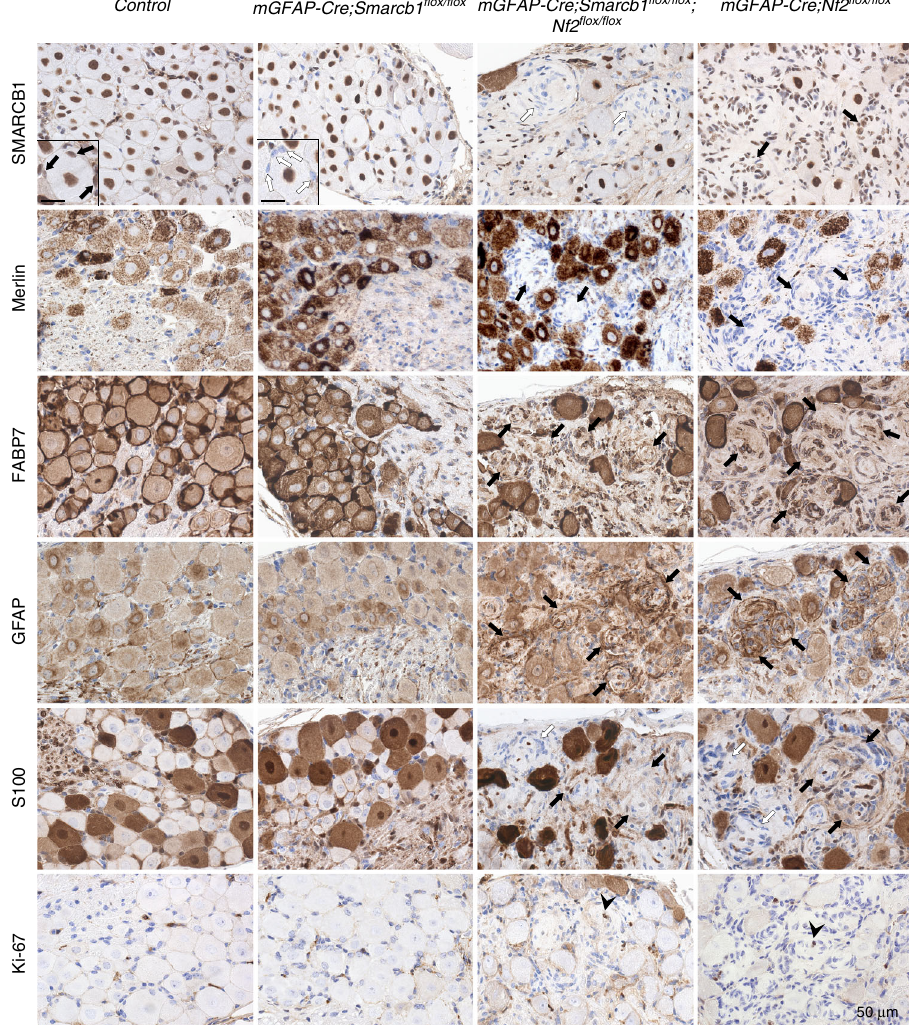
Fig. 6 Histological characterization of DRGs and schwannoma tumorlets in control, mGFAP-Cre;Smarcb1 fl ox/ fl ox , mGFAP-Cre;Smarcb1 fl ox/ fl ox ;Nf2 fl ox/ fl ox , and mGFAP-Cre;Nf2 fl ox/ fl ox mice. DRGs from mGFAP-Cre;Smarcb1 fl ox/ fl ox mice present loss of SMARCB1 nuclear staining ( white arrows ), but no tumorlets or increased Ki-67 immunopositive staining. Tumorlets in DRGs of mGFAP-Cre;Smarcb1 fl ox/ fl ox ;Nf2 fl ox/ fl ox mice show loss of both SMARCB1 and merlin ( white and black arrows ), and tumorlets in DRGs of mGFAP-Cre;Nf2 fl ox/ fl ox mice show loss of merlin only ( black arrows ). Both tumorlets from mGFAP-Cre; Smarcb1 fl ox/ fl ox ;Nf2 fl ox/ fl ox and mGFAP-Cre;Nf2 fl ox/ fl ox mice show strong positive staining for FABP7 and GFAP ( black arrows ). Tumorlets from these both genotypes are S100 positive ( black arrows ) or negative ( white arrows ). Ki-67 positive staining is found in tumorlets of both mGFAP-Cre;Smarcb1 fl ox/ fl ox ; Nf2 fl ox/ fl ox and mGFAP-Cre;Nf2 fl ox/ fl ox mice ( arrowhead ). Inset scale bar : 15 µ